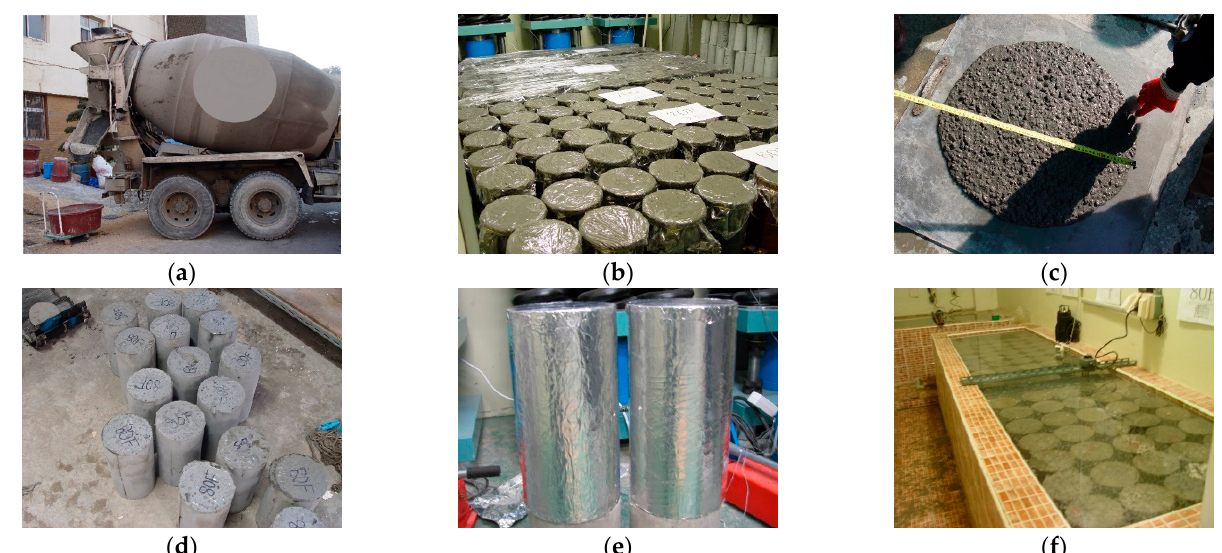
Figure 2. Specimen production and test preparation: ( a ) concrete mixing in batcher plant; ( b ) evaluation of fresh concrete; ( c ) production of specimens; ( d ) demolding of the specimen; ( e ) curing; ( f ) pretreatment of specimen.